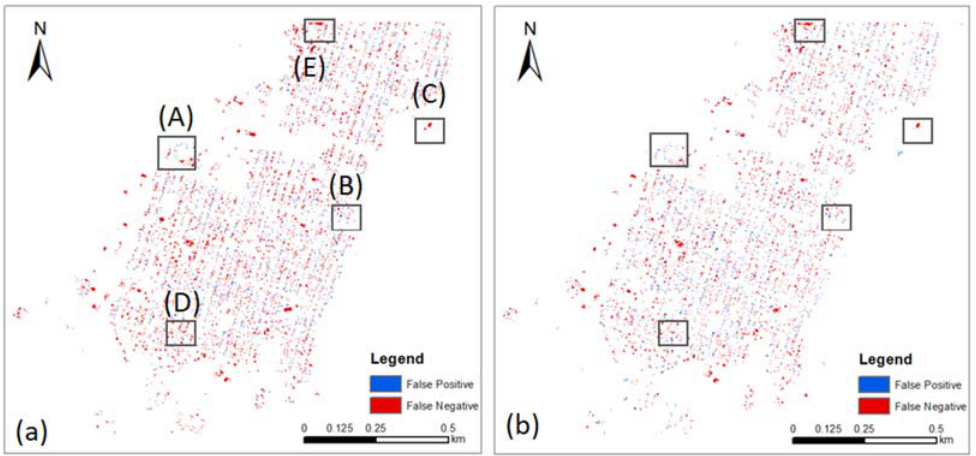
Figure 8. The spatial distribution of predicted FP (blue) and FN (red) pixels of the OBIA ‐ OCOS model ( a ) and the Manual ‐ OCOS model ( b ) from the Kule Wet case.